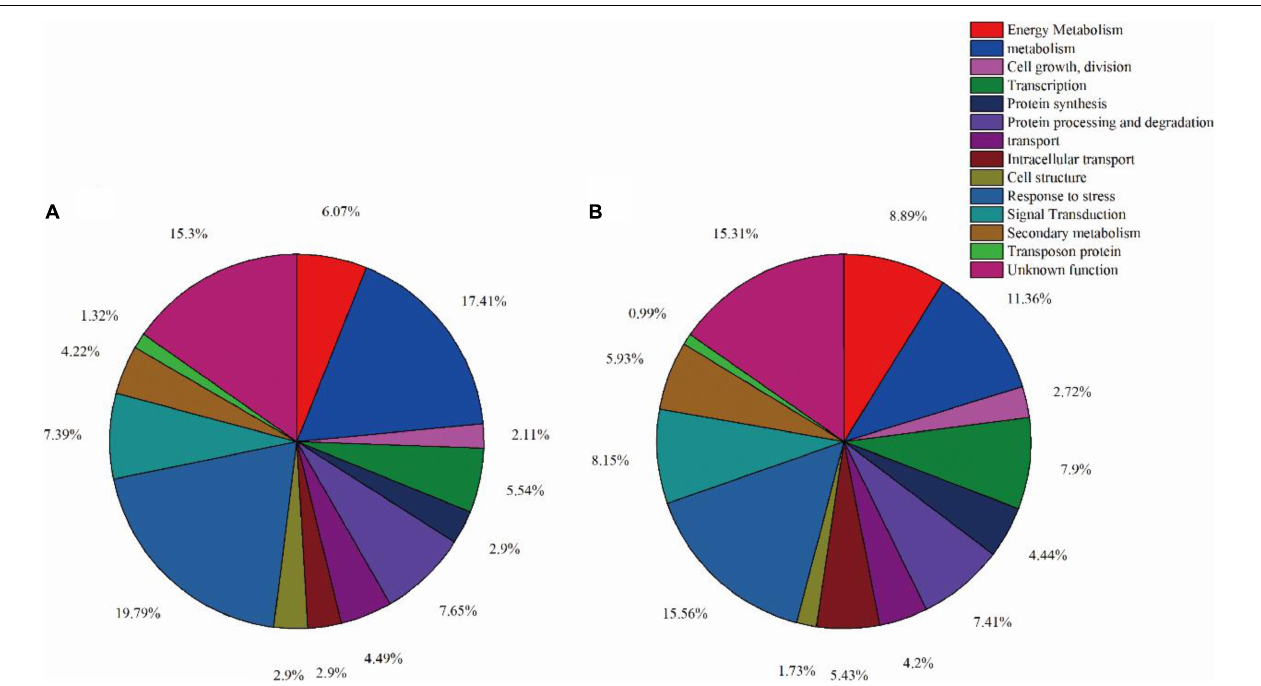
FIGURE 6 | Function classification of differentially expressed proteins in leaves at three-leaf stage (A) and tillering stage (B)